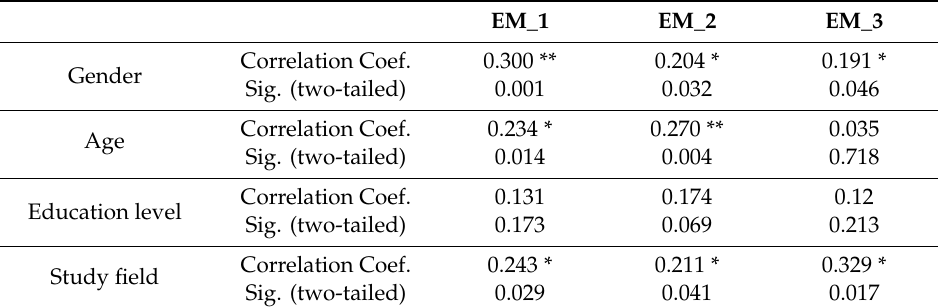
Table 14. Correlation analysis (2).